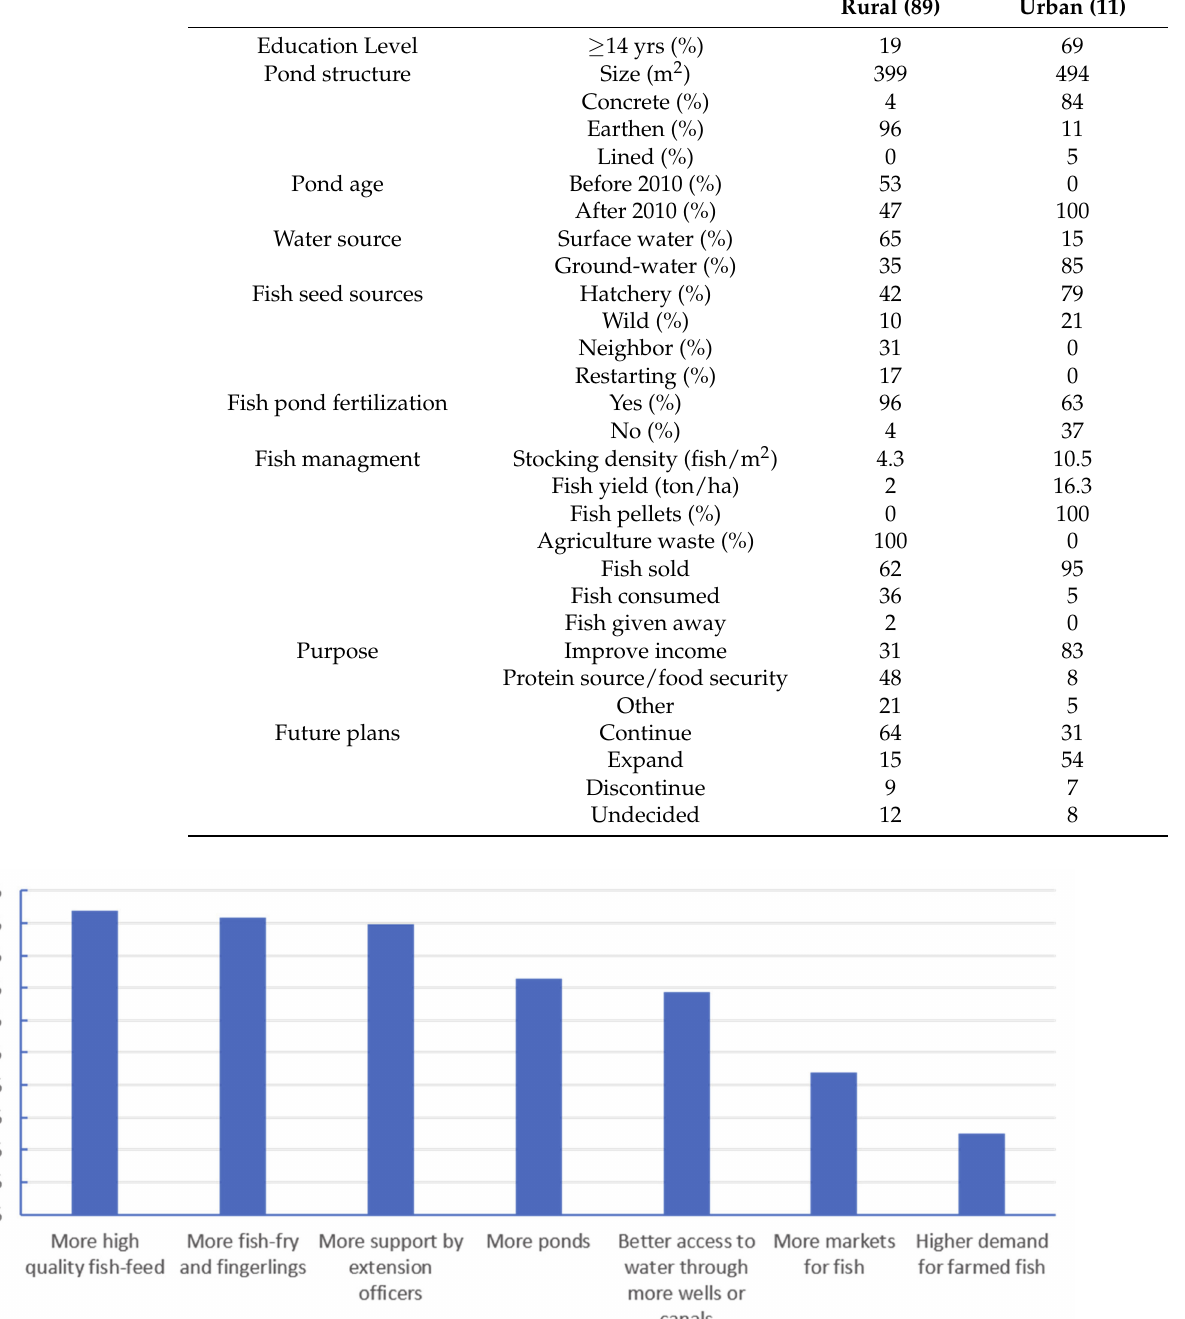
Table 7. Characteristics of urban (commercial, 11) and rural (subsistence, 89) pond farming in Tanzania.